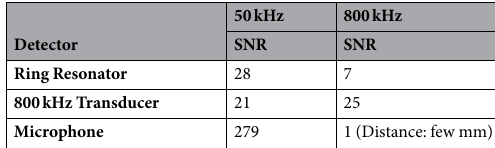
Table 1. SNR of Ultrasound Detectors at 50 kHz and 800 kHz.